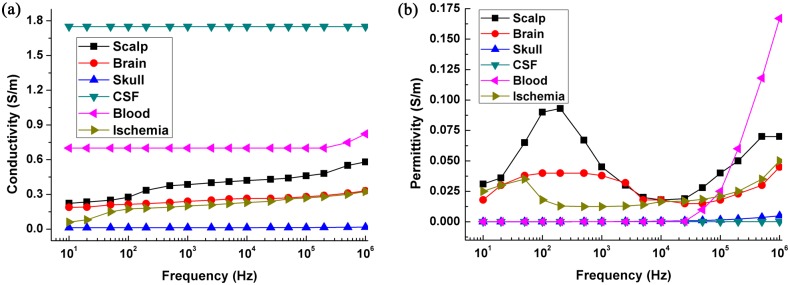
The dielectric parameters of head tissues, hemorrhagic tissue and ischemic tissue.